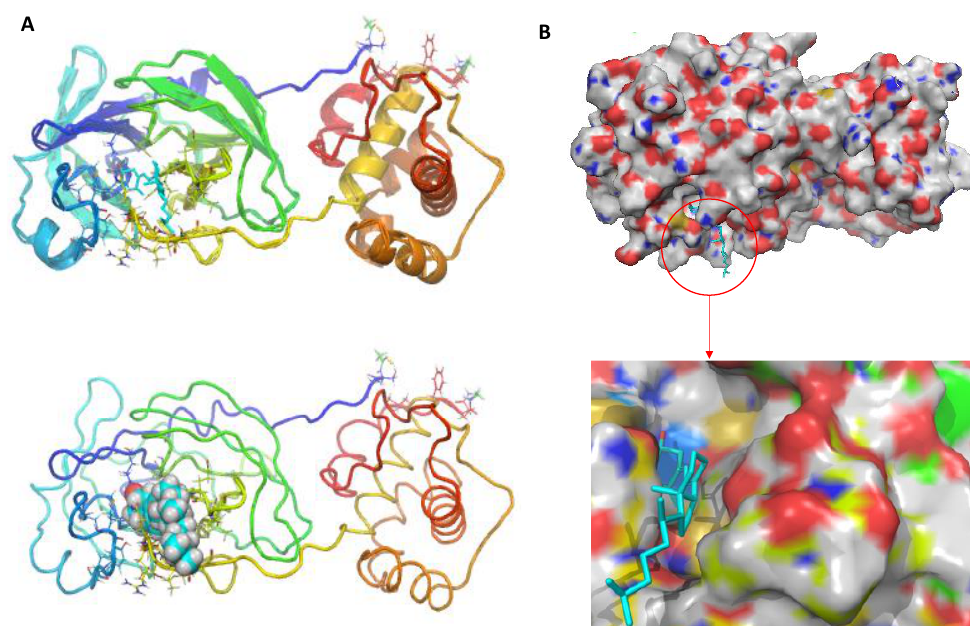
Figure 2. ( A ) The predicted binding mode of the 25-hydroxy vitamin D at the active site of SARS- CoV-2 major protease ( B ) Representation of surface image of 25-hydroxy vitamin D binding at the active site of SARS-CoV-2 major protease.